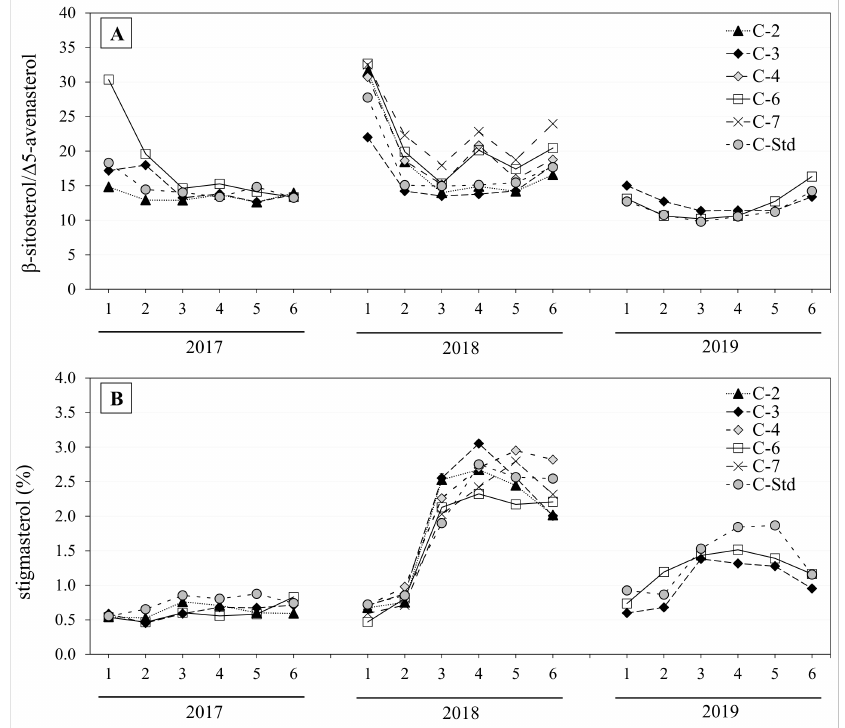
Figure 2. Evolution of the ratio of β -sitosterol/ ∆ 5-avenasterol ( A ) and stigmasterol ( B ) by clone (C-2, C-3, C-4, C-6, C-7 and C-Std) throughout sampling in the 2017, 2018, and 2019 crop years. Harvest dates: 1 (1–4 October), 2 (16–18 October), 3 (28 October–7 November), 4 (11–22 November), 5 (25–29 November) and 6 (11–13